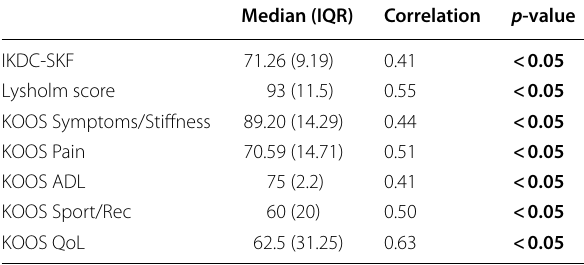
Bold values indicate statistical